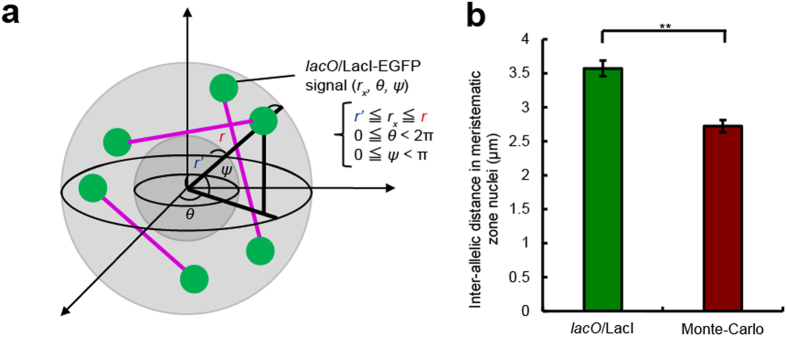
Simulation analysis of the distance between homologous loci using a mathematical model.a, Mathematical model mimicking a nucleus in the meristematic zone of A. thaliana roots. This model simulated random inter-allelic distances (drawn in purple lines) in the nucleoplasm and calculated their average. b, Comparison between the measured value (lacO/LacI) and the simulated value (Monte Carlo) (n = 105, **P < 0.01).